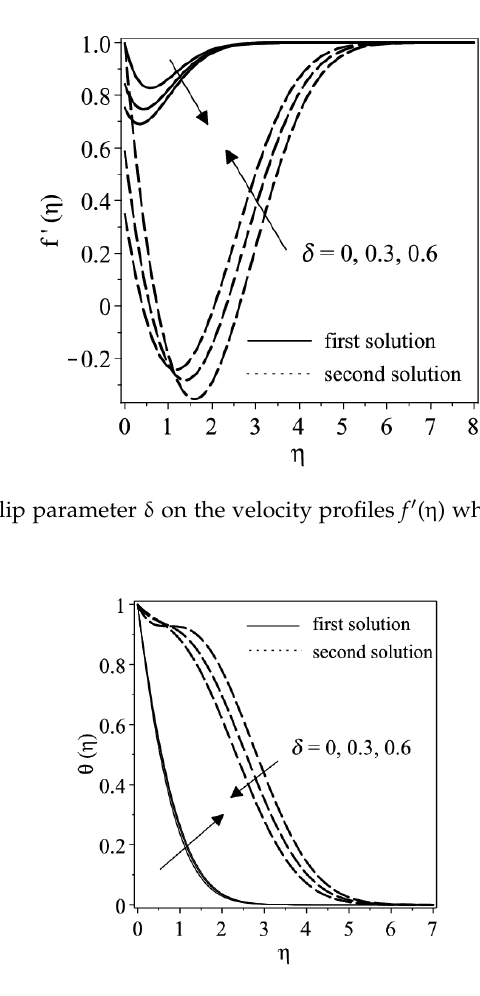
Figure 4. Effect of the slip parameter δ on the temperature profiles θ ( η ) when ε = 1, Pr = 1 and λ = ´ 2 (opposing